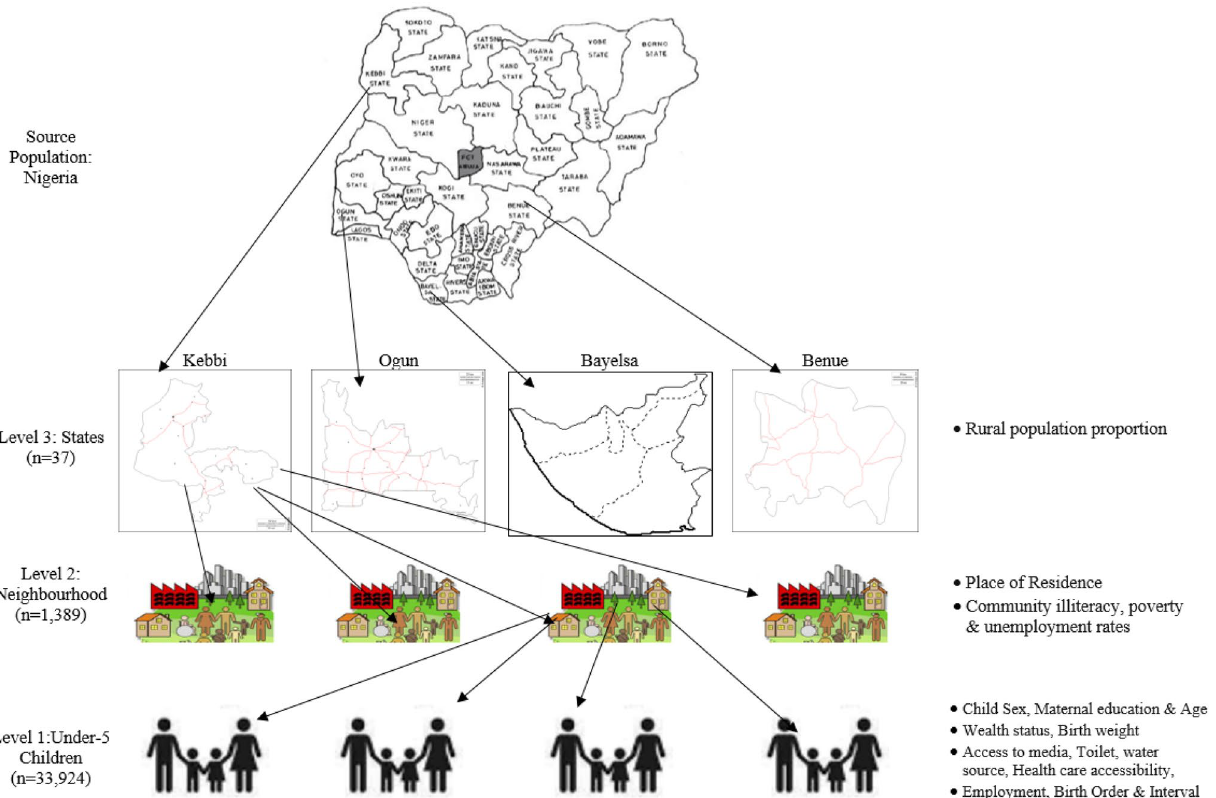
Figure 1. Hierarchical nature of the data structure. Source: Authors